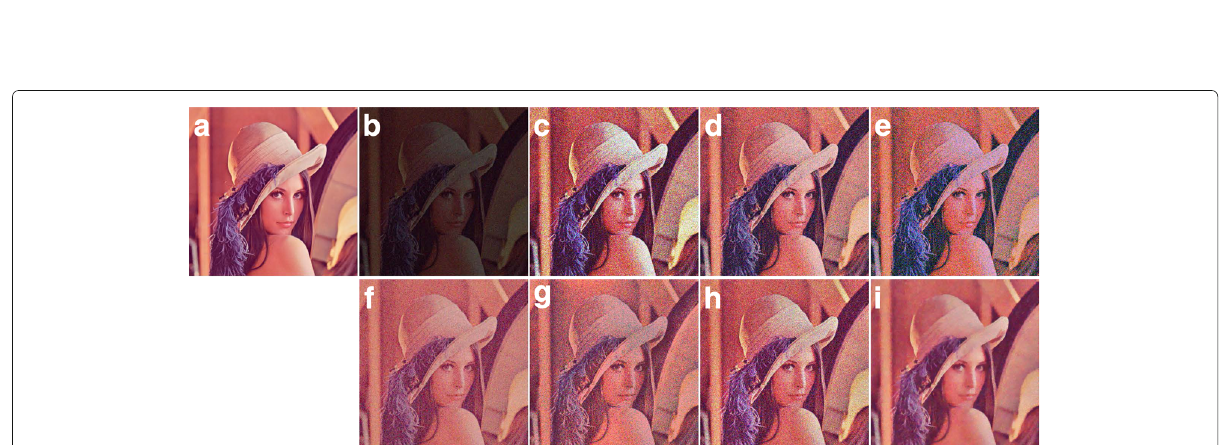
Fig. 7 Comparative results using simulated low-light image with σ = 15: a input image, b simulated low-light image, c Chen’s method [2], d Kim’s method [3], e Jiang’s method [8], f Ravi’s method [23], g Jobson’s method [14], h Fu’s method [16], and i the proposed method ( λ 1 = 300, λ 2 = 0.2, = 0.9, and ω = 10) λ 3